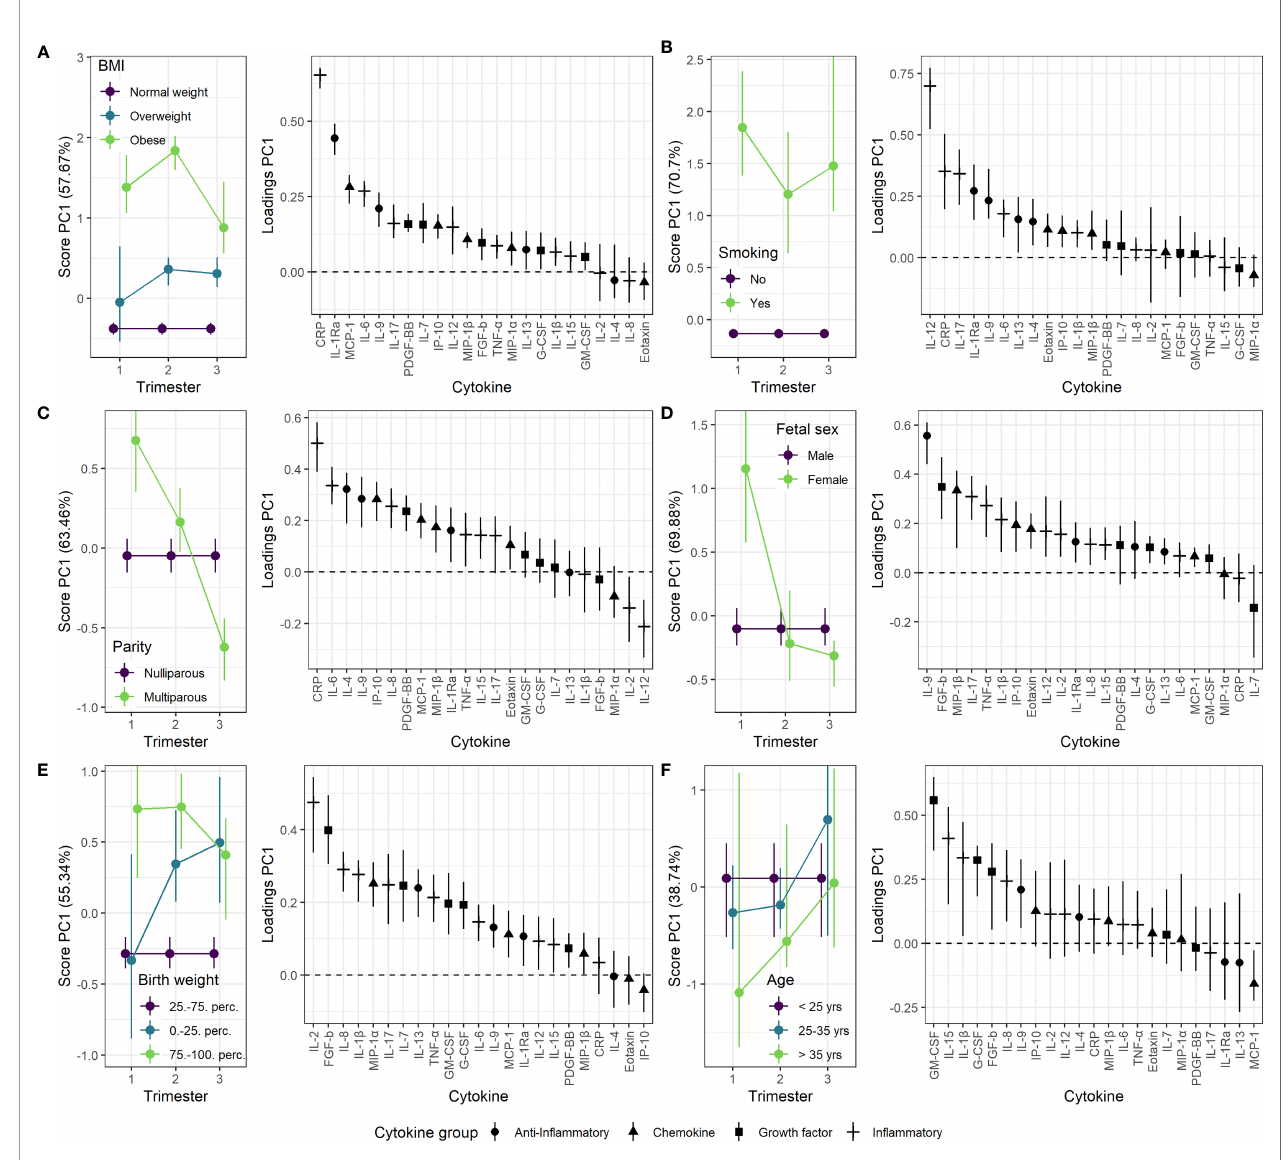
FIGURE 4 | Impact of clinical parameters on the maternal serum cytokine pro fi le from fi rst trimester to term. Serum cytokine pro fi les throughout pregnancy for (A) overweight and obese women relative to normal weight women, (B) smoking compared to non-smoking women, (C) multiparous compared to nulliparous women, (D) pregnancies with a female fetus compared to male fetus, (E) pregnancies with birth weight above the 75 th percentile or below the 25 th percentile of expected sex-speci fi c birth weight compared to those within 25 th -75 th . percentile, and (F) mothers between 25-35 years and above 35 years of age compared to mothers below 25 years of age. Loadings (right panels) describe the contribution of each cytokine to the corresponding scores (left panels). Higher score translates to higher levels of cytokines with positive loading and lower levels of cytokines with negative loading, and vice versa. The scores describe relative differences between groups and must be interpreted in relation to corresponding time trajectories ( Figure 3